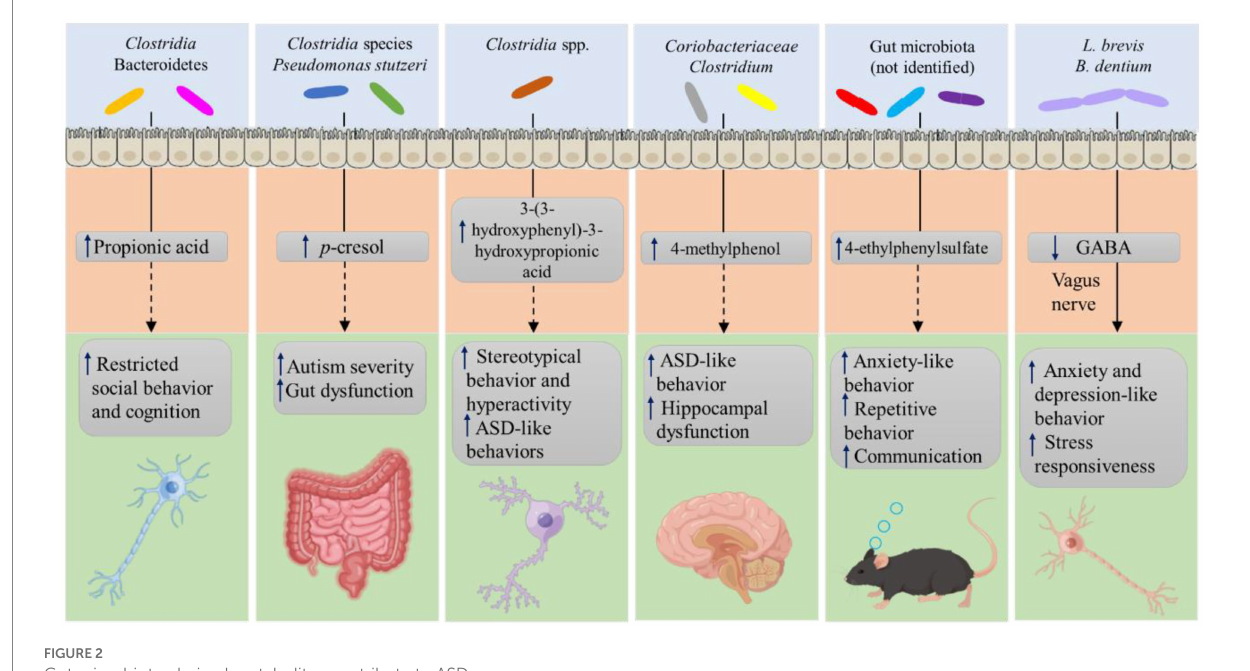
FIGURE 2 Gut microbiota-derived metabolites contribute to